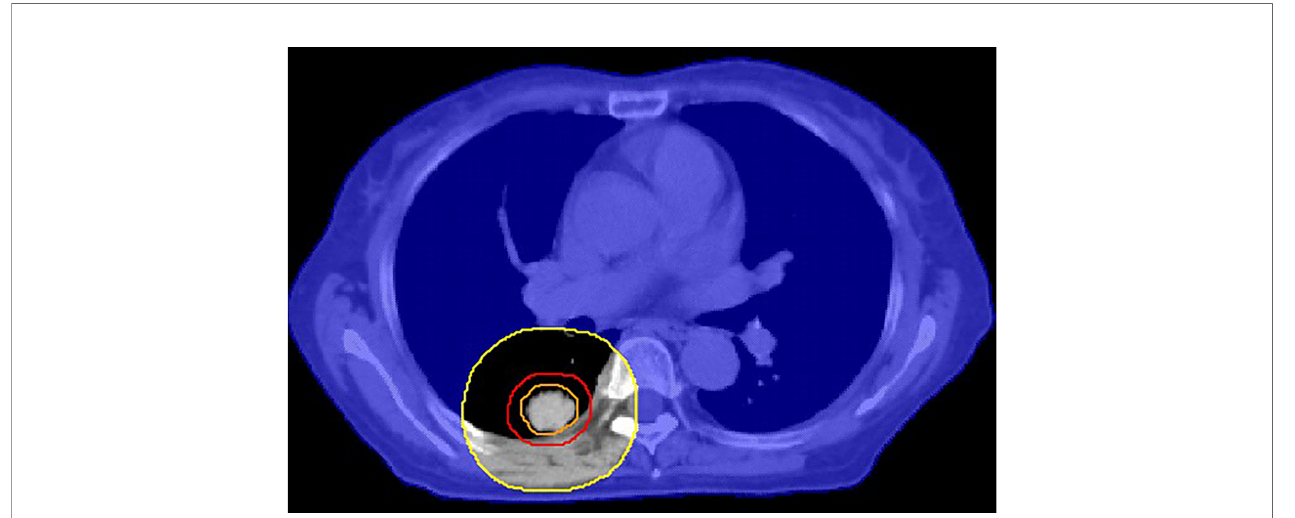
FIGURE 4 | An example of a cross-sectional view of the shell (orange: ITV, red: PTV, yellow: auxiliary structure after GM cm expansion of PTV, blue shade: GM cm shell obtained by body minus auxiliary structure). This shell is used to control the 50% isodose line.